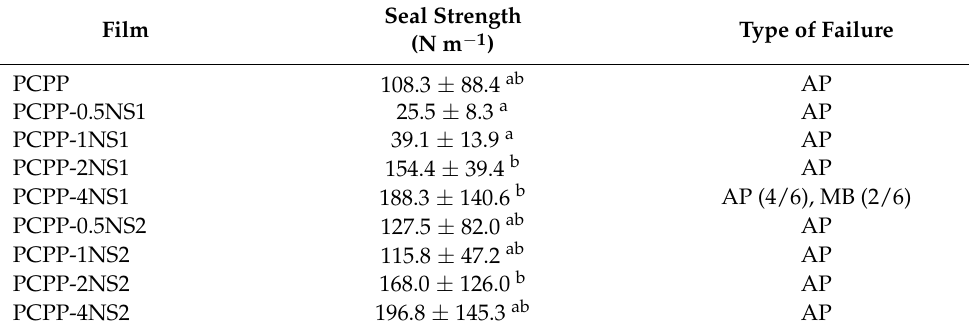
Table 2. Seal strength of the nanocomposites.